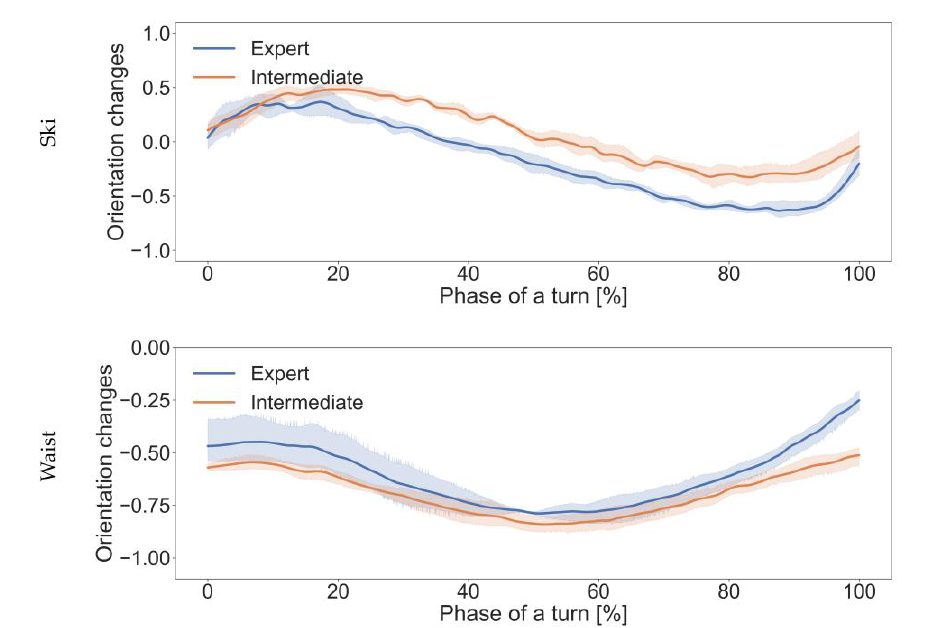
Figure 7. Orientation changes of ski and waist in one ski-turn phase for the direction of travel. Each orientation change was calculated from quaternions of each inertial sensor. The ( top ) plots ski data and the ( bottom ) plots waist data. The blue line is for the expert skier and the orange line is for the intermediate